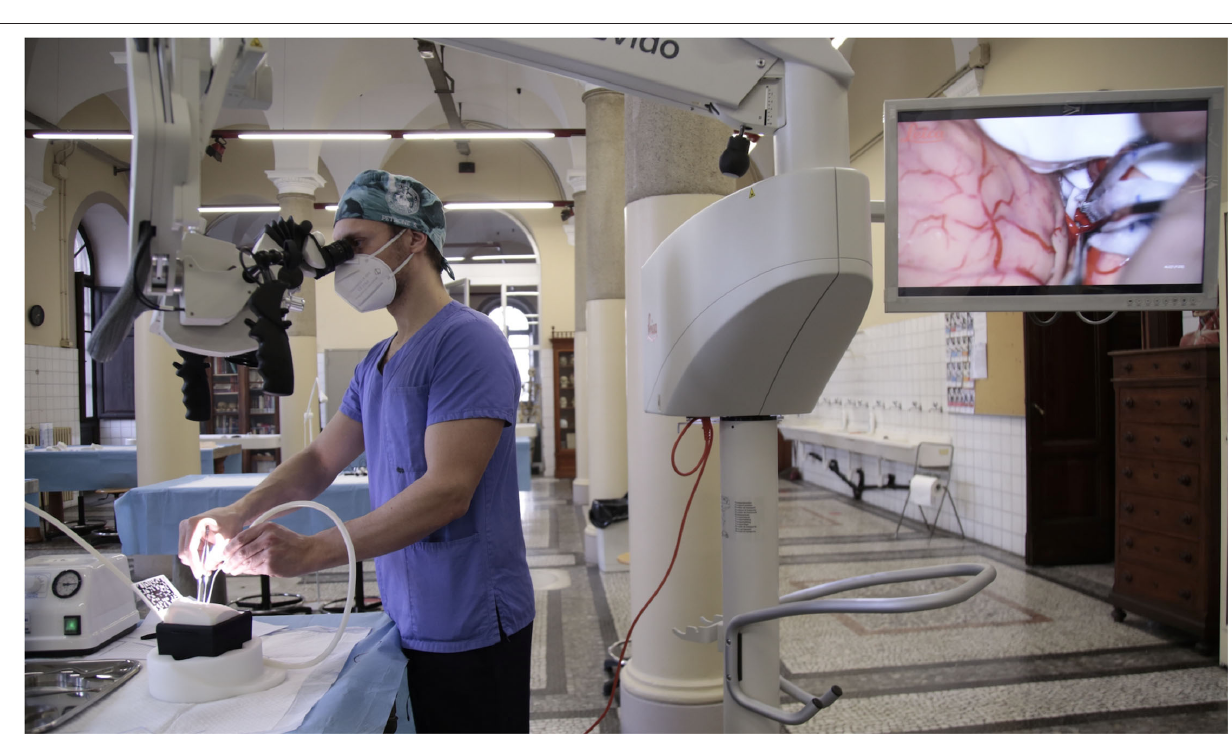
FIGURE 3 | Workstation set up with microscope and